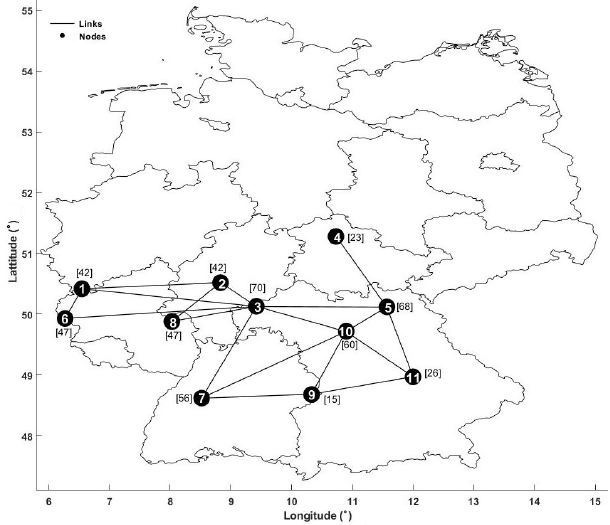
Figure A1. Location of 11 randomly selected rain stations used to construct a complex network based on the cross-correlation similarity measure and 90th percentile threshold. Diagonal values (autocorrelation) in Table 1 have been ignored in network construction. Numbers 1 to 11 are node counts, and the values in brackets represent the WDB values.